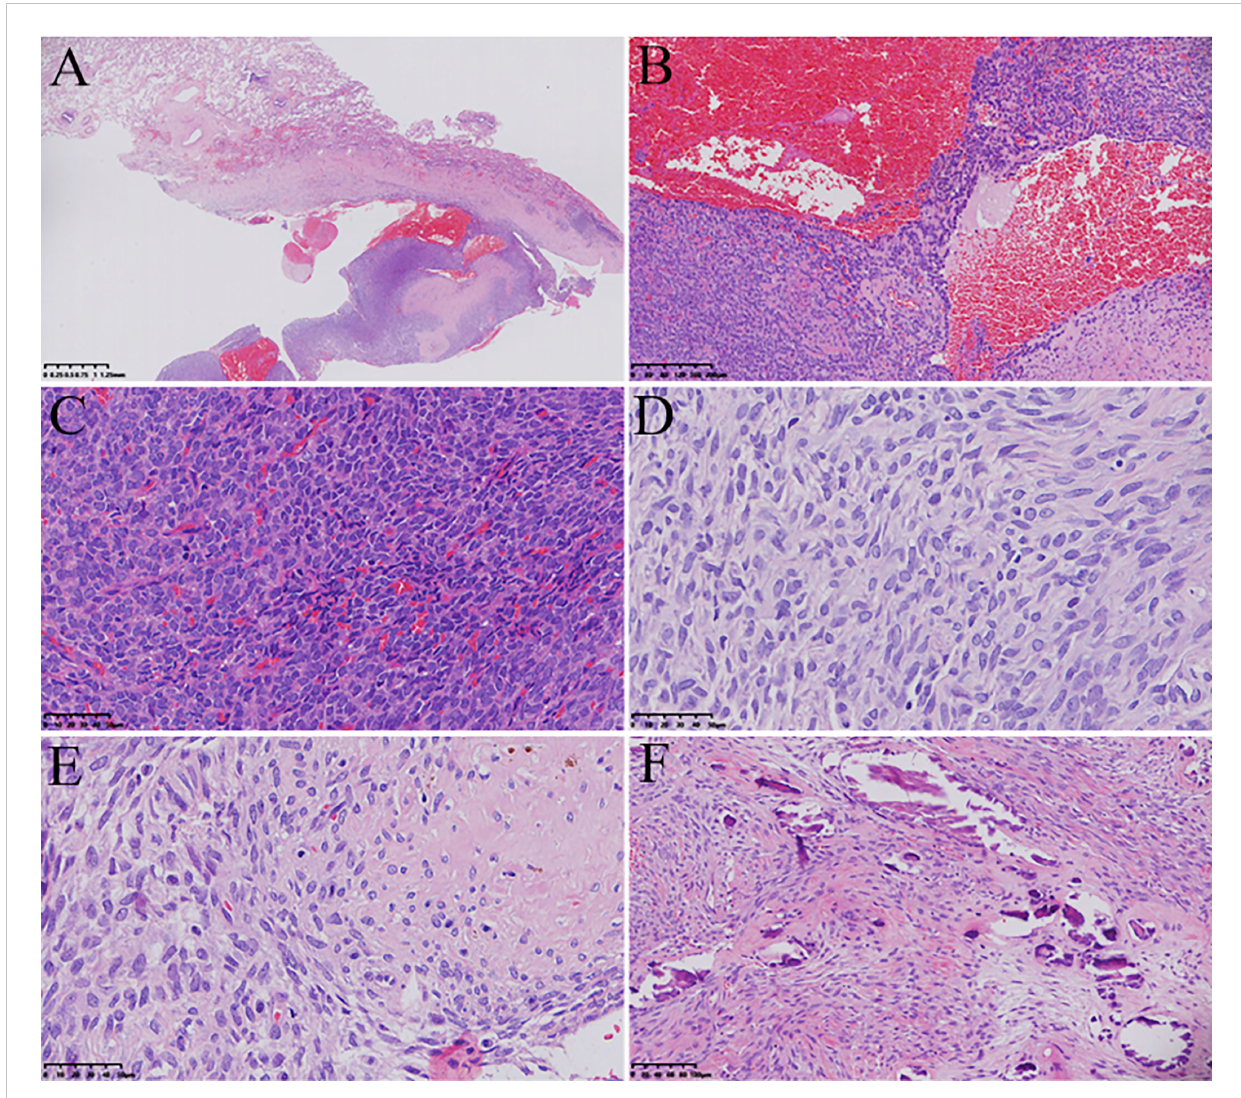
FIGURE 3 Morphology. (A) Scanning power showing normal alveolar structure in the upper left corner, and the tumor (underneath) is clearly separated from the lung tissue via pleural thickening. (B) A dilated hemorrhagic focus around the tumor, similar to cavernous hemangioma or hemangiopericytoma. (C) In the dense area of the tumor cells, the cells are round or irregular in shape, with less cytoplasm, uniform nuclear chromatin, and visible nucleoli and mitoses (2/10 HPF). (D) In the sparse area of the tumor cells, the cells are arranged in a fascicular, whorled, storiform and meningithelial pattern, with unclear borders between cells. These cells do not exhibit any obvious atypia, with fi ne chromatin, inconspicuous nucleoli, and rare mitotic fi gures. (E) Interstitial hyaline degeneration. (F) Presence of many psammoma